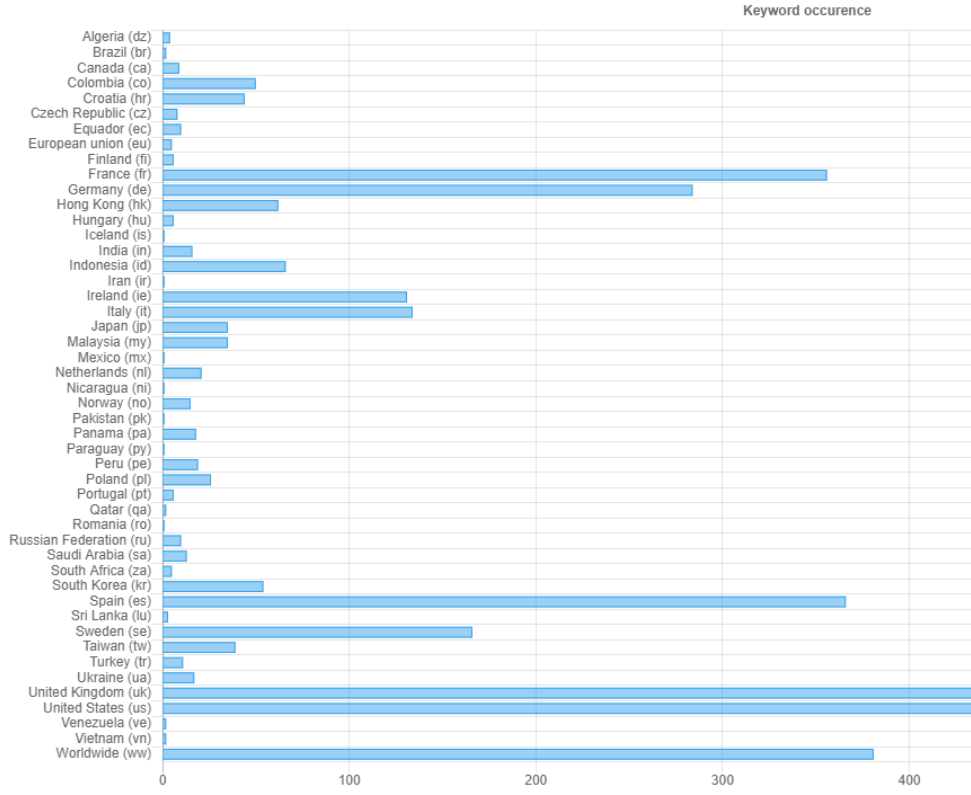
Figure 11. Occurrence of SOA in paper abstracts in different countries (Horizontal scale shows number of papers related to a topic per country).